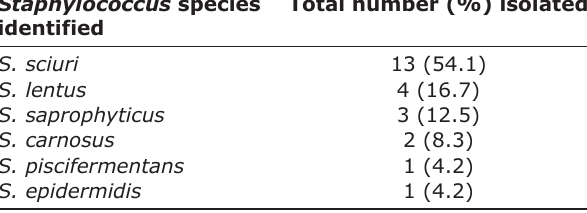
Table-4: Antimicrobial susceptibility profile of Staphylococcus species (n=24) isolated from ready-to-eat